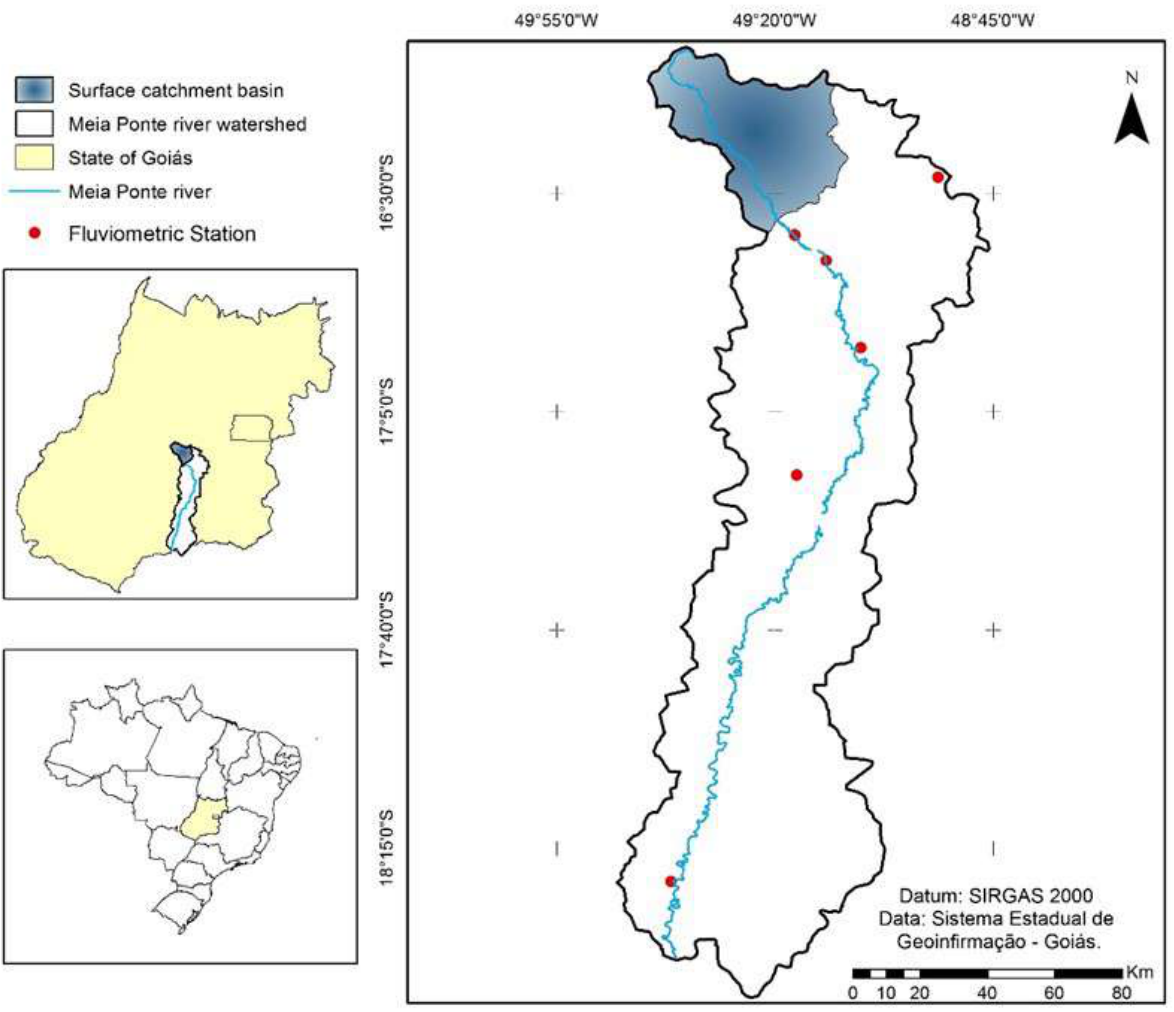
possible to apply regression models with the dependent variable being the reference flow present 95% of the time (Q ) and the independent variable being the area of con- 95 tribution of the fluviometric stations. The equations were obtained using SisCORV 1.0 software and adjusted us- ing five different regression models: linear model, poten- tial model, exponential model, logarithmic model and re- ciprocal model, according to Equations 1, 2, 3, 4 and 5 [2, 12,